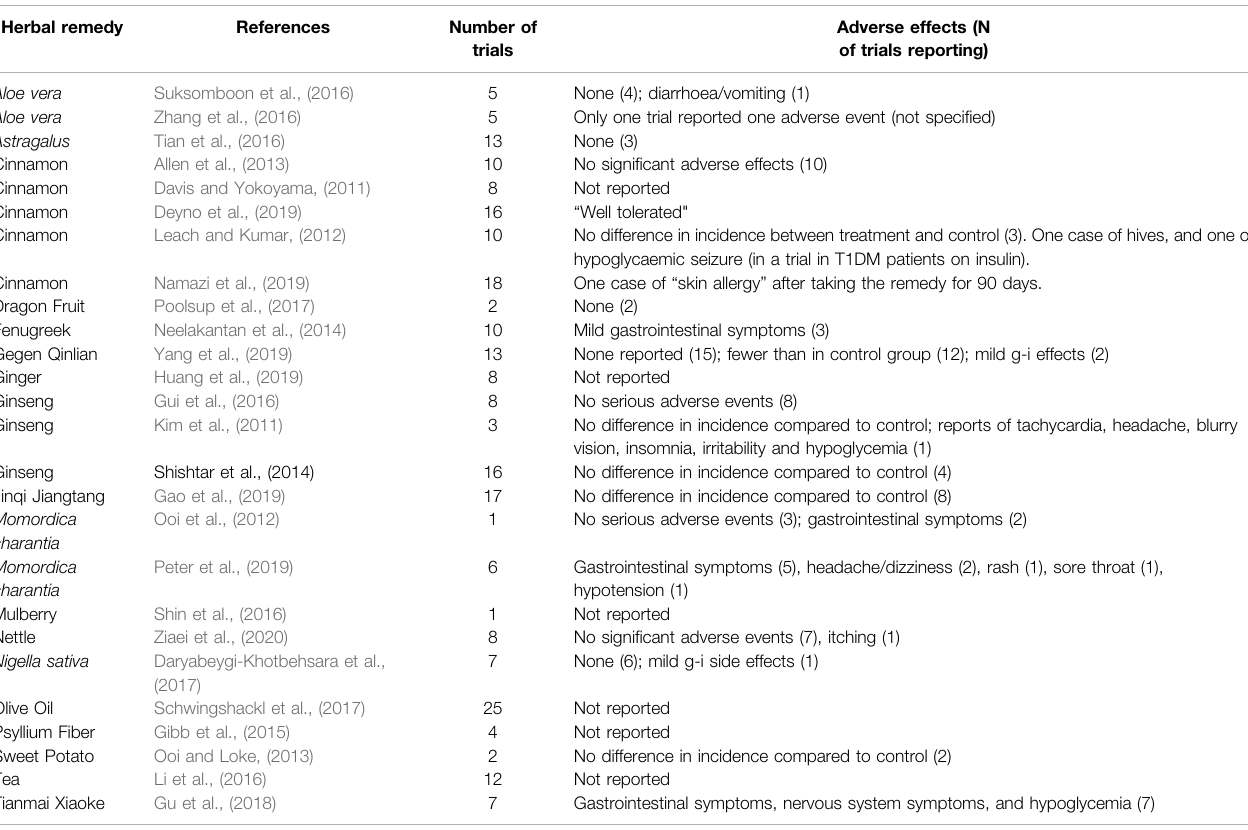
TABLE 2 | Reported adverse